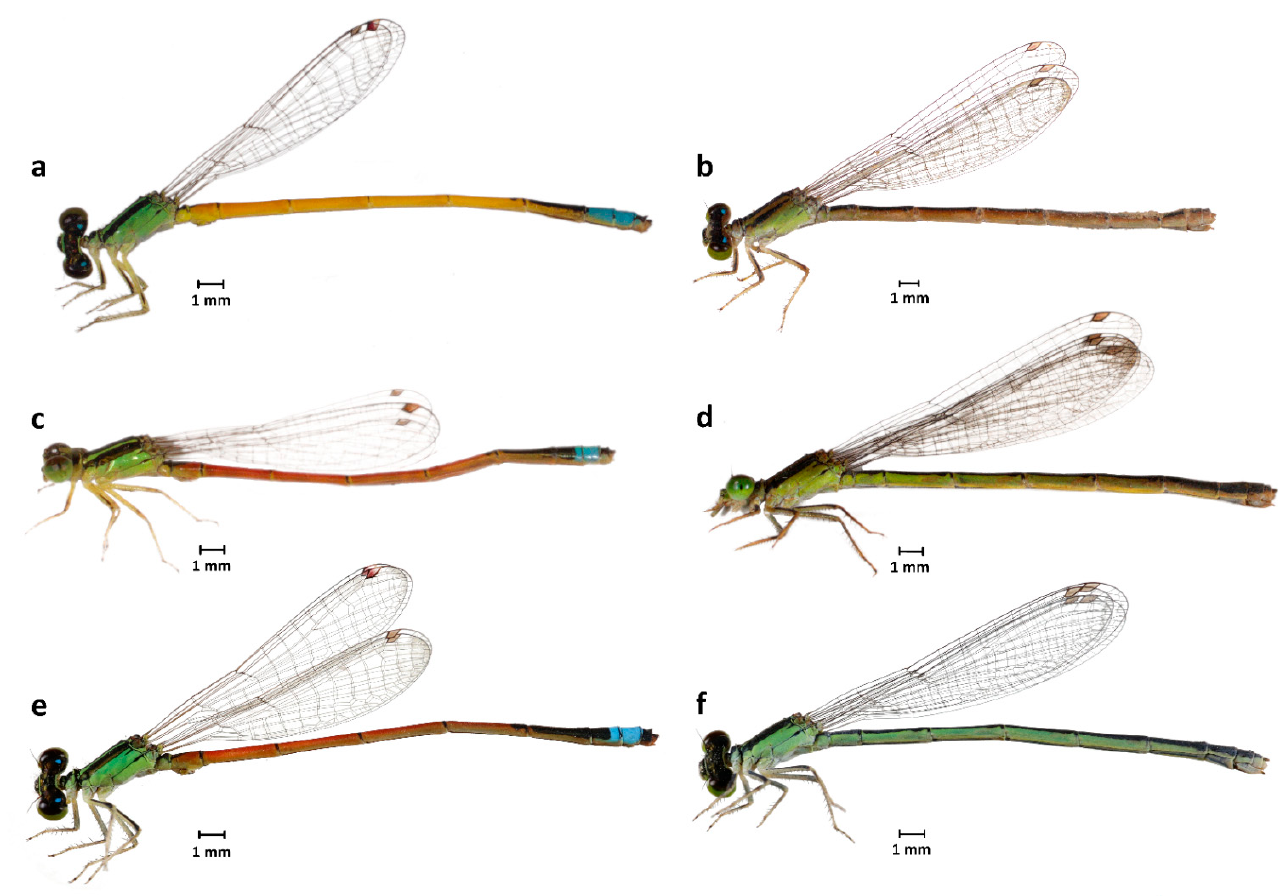
Figure 4. Lateral view of specimens of Ischnura aurora from China (( a ) male; ( b ) female), Australia (( c ) male, ( d ) female), and Fiji (( e ) male, ( f ) female). Due to the poor state of preservation of the I. rubilio specimens, it was not possible to add an image of this species, but its morphology was similar to that observed in the I. aurora from